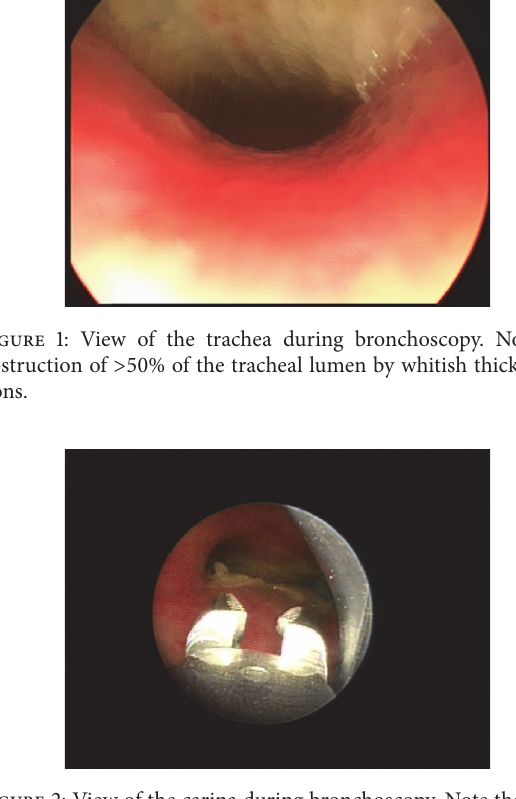
Figure 2: View of the carina during bronchoscopy. Note the thick, pseudomembranous white material obstructing a great portion of both mainstem bronchi and the optical foreign body forceps in place used to gently remove